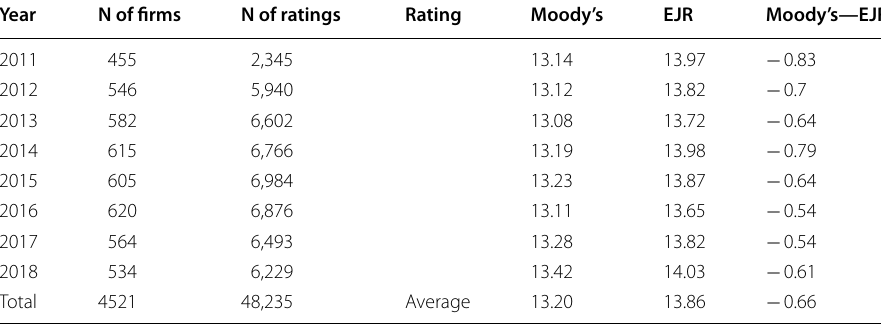
This table reports the average number of firms and firm-month ratings in the sample. We also report the average ratings given by Moody’s and EJR each